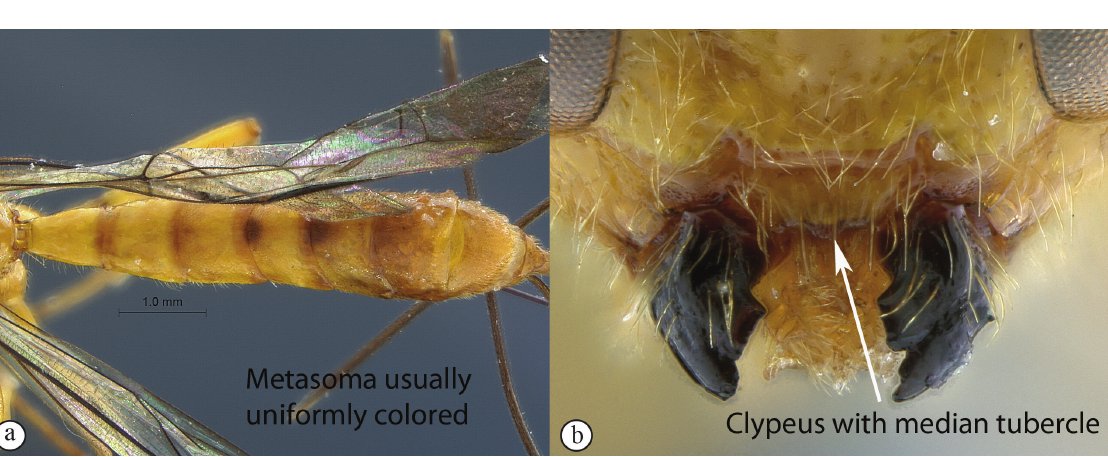
Metasoma usually uniformly colored (a); clypeus with a distinct subapical tubercle (b); body and